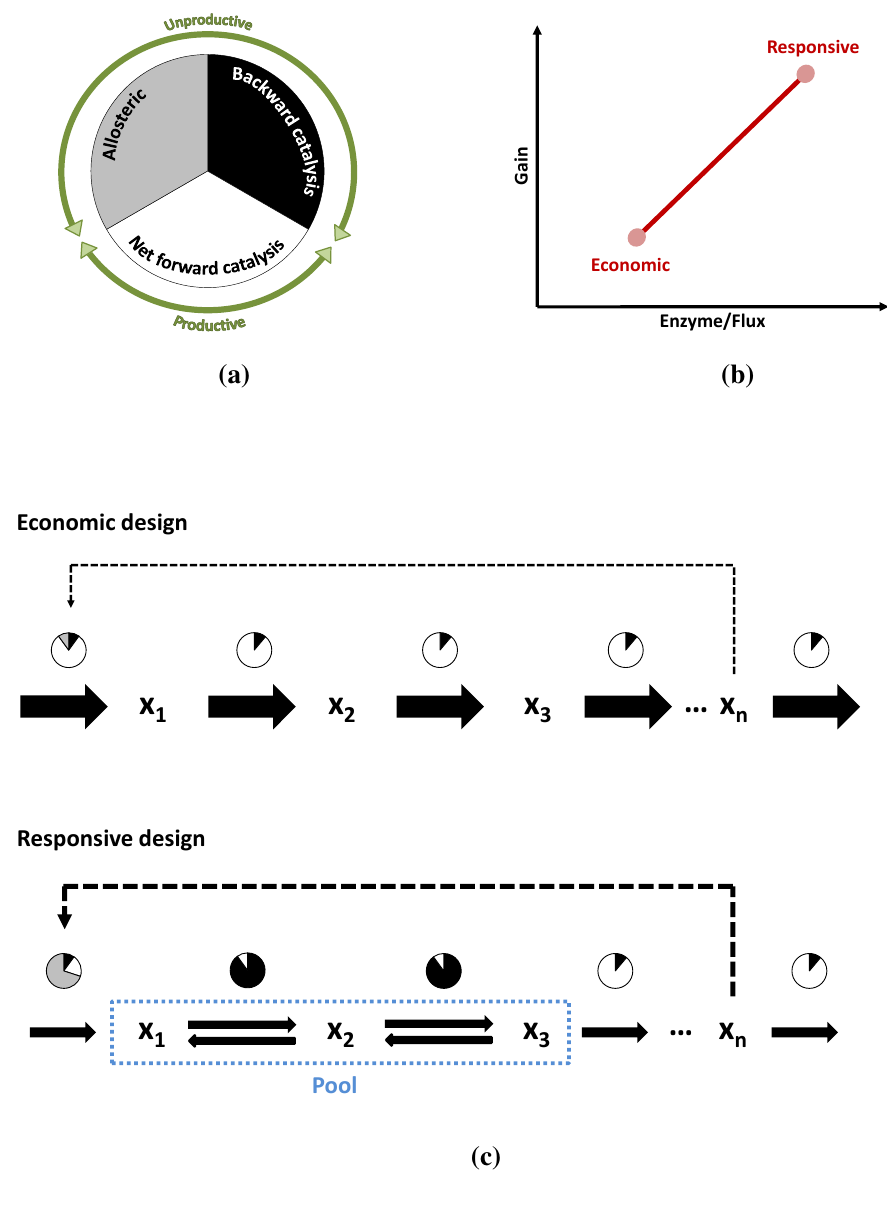
Figure 10. The circles in ( a , c ) schematically show the reduction of enzyme activity due to different causes (graphical depiction of the η terms in Equation (6)). In white, the fraction of the enzyme that is actually catalyzing the reaction forward. In grey the fraction that is inactive due to allosteric inhibition (or more exactly the fraction in which the total activity is reduced). In black, the fraction of activity that is lost due to the flux of the reverse reaction or due to insaturation of the enzyme; ( b ) Shows the two alternative pathways in performance space and the trade-off between them; ( c ) A more detailed depiction of the two modes of operation: The economic variant carries a high flux and all its enzymes are operating close to their V due to weak inhibition and distance to equilibrium. In the responsive variant, max the first enzyme is inhibited and two of the reactions are close to equilibrium. The efficiency of the enzymes is much lower but so is the flux they have to